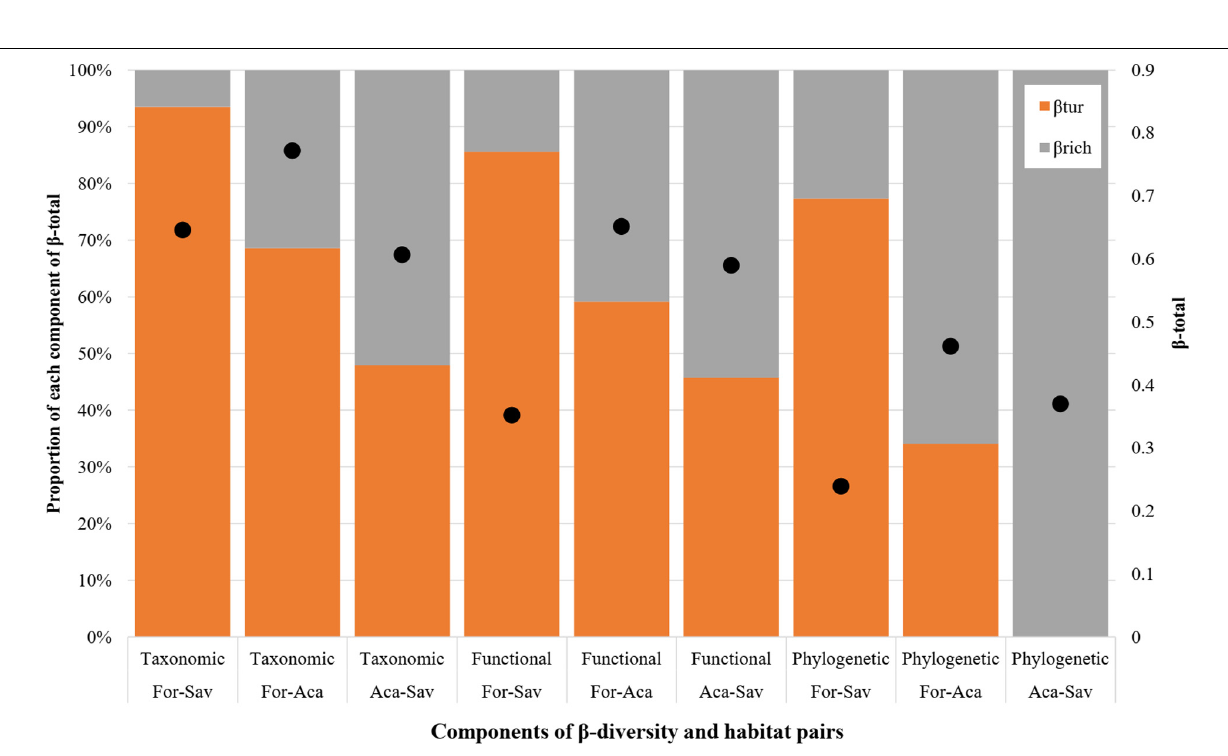
Frontiers in Ecology and Evolution |